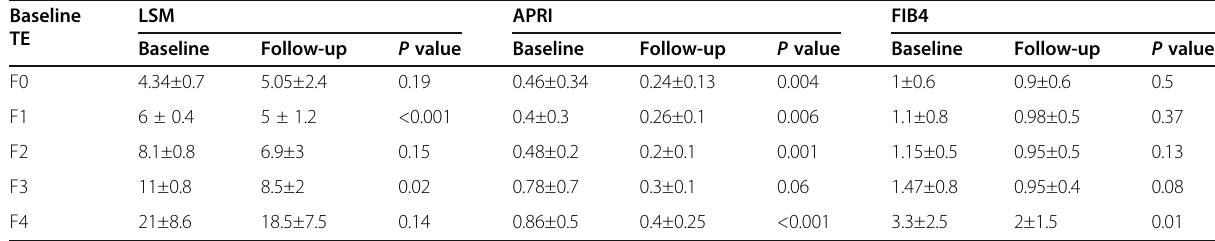
Table 6 Subgroup analysis of changes in fibrosis scores Baseline LSM TE